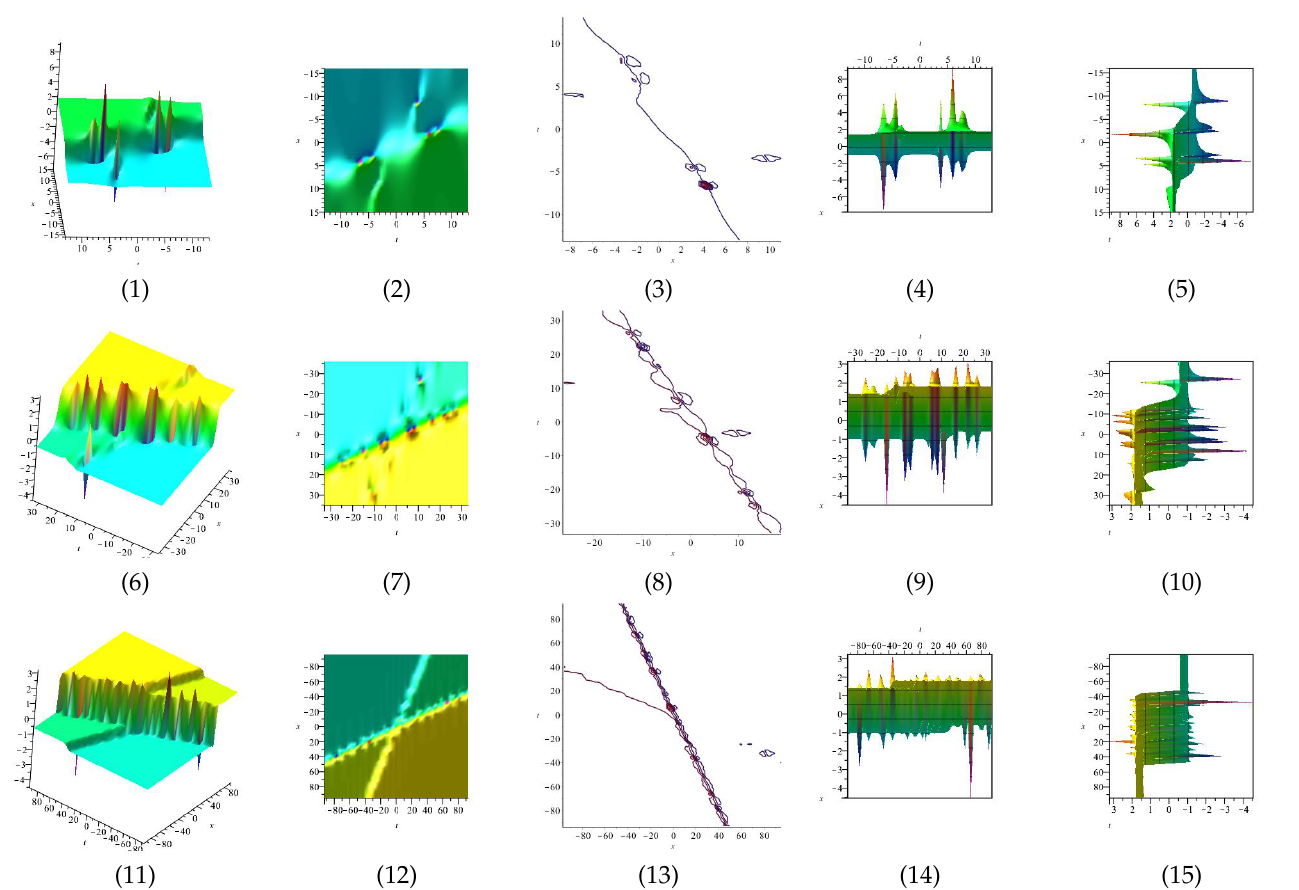
Figure 13. The 3D and 2D with the diagrams of the real part of equation u 3,1 , in three different